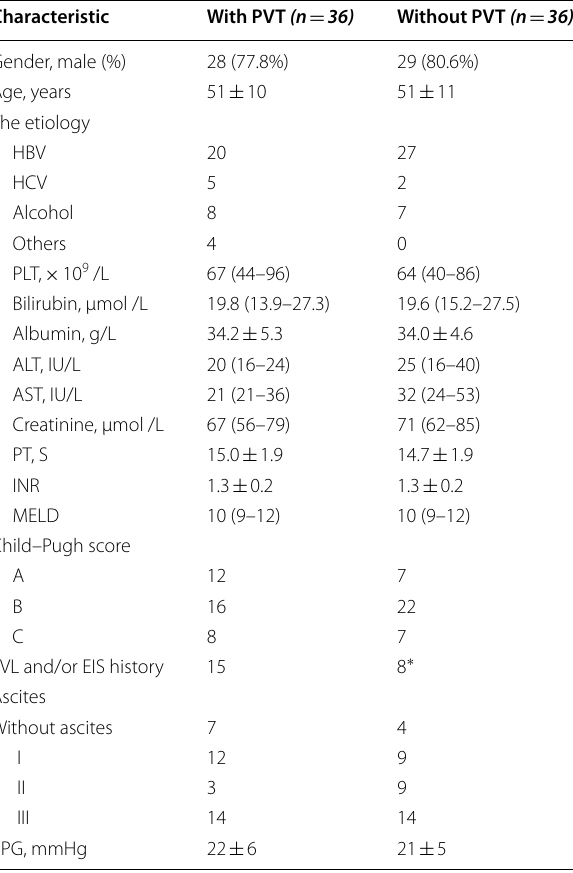
Table 1 Baseline characteristics of enrolled